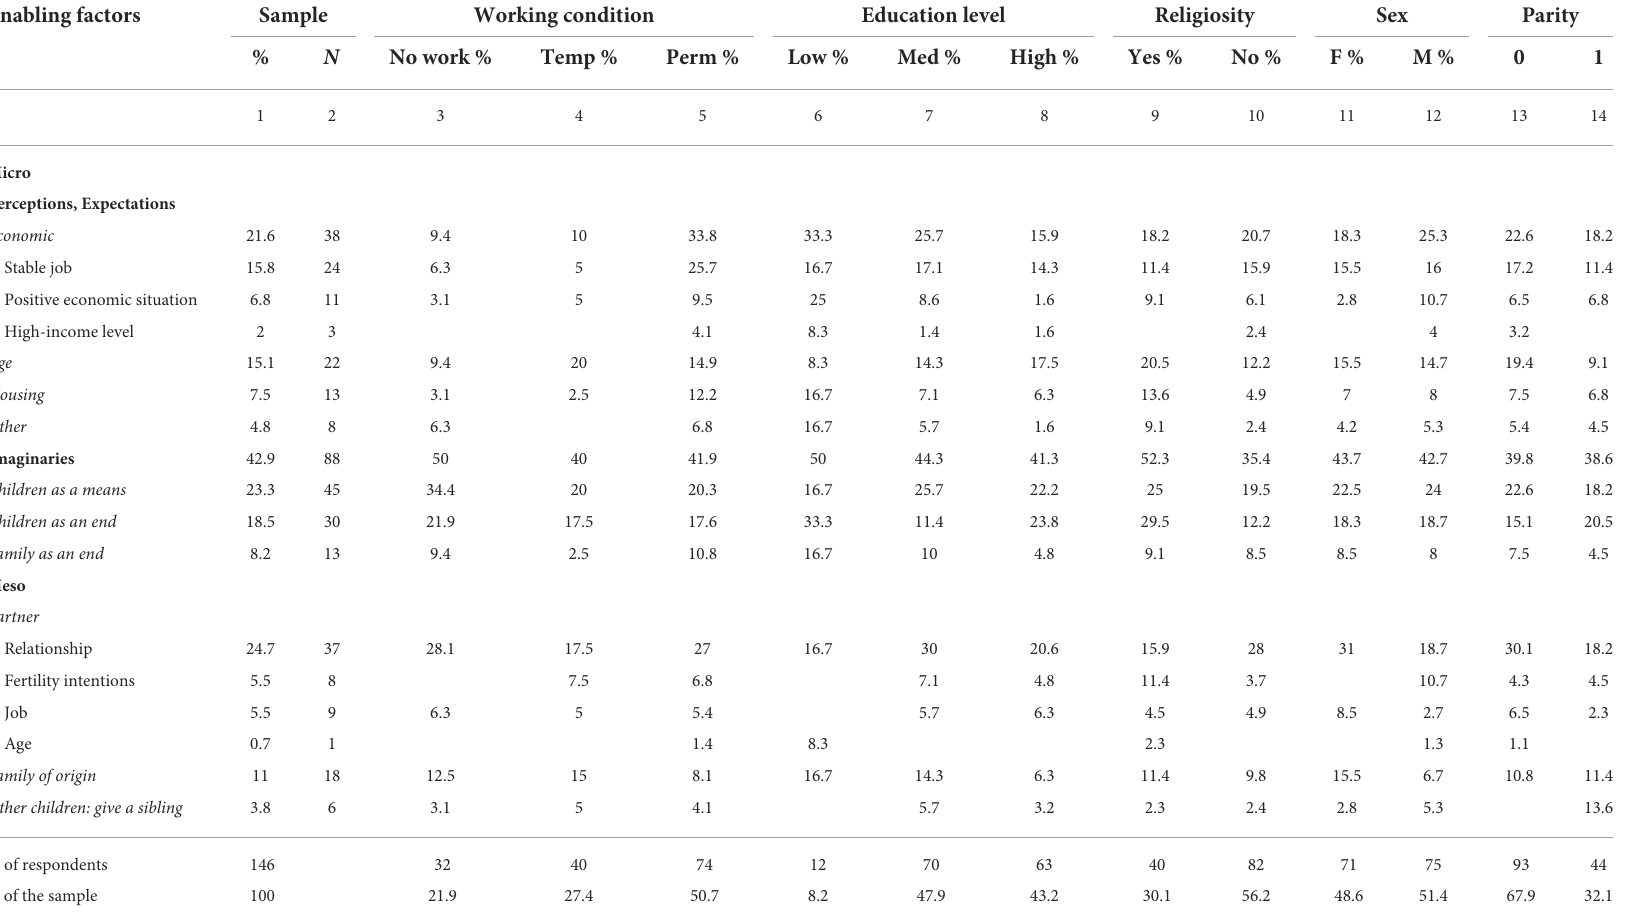
TABLE 4 Code frequencies of the enabling factors to fertility intentions for the achieved capability